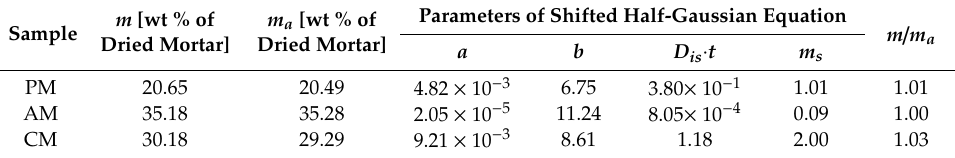
Table 8. Total amount of natural di ff used chloride computed by the half-Gaussian di ff usion model.